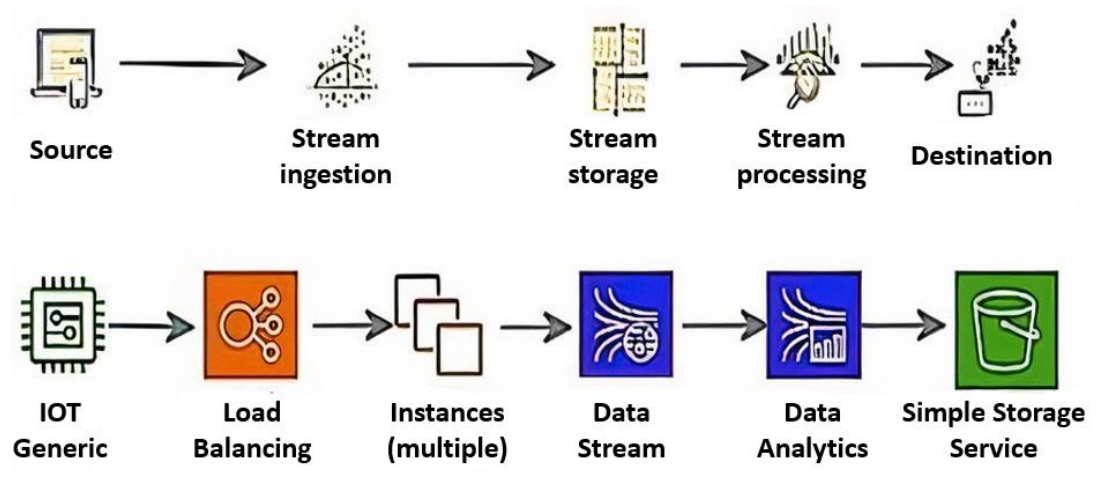
Figure 8. Simulation Model [13].